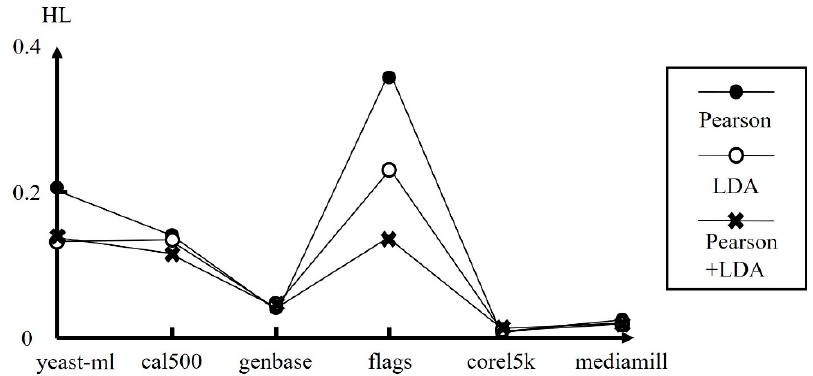
Figure 7. Performance of ML-Scheme with Pearson, LDA, and Pearson+LDA.